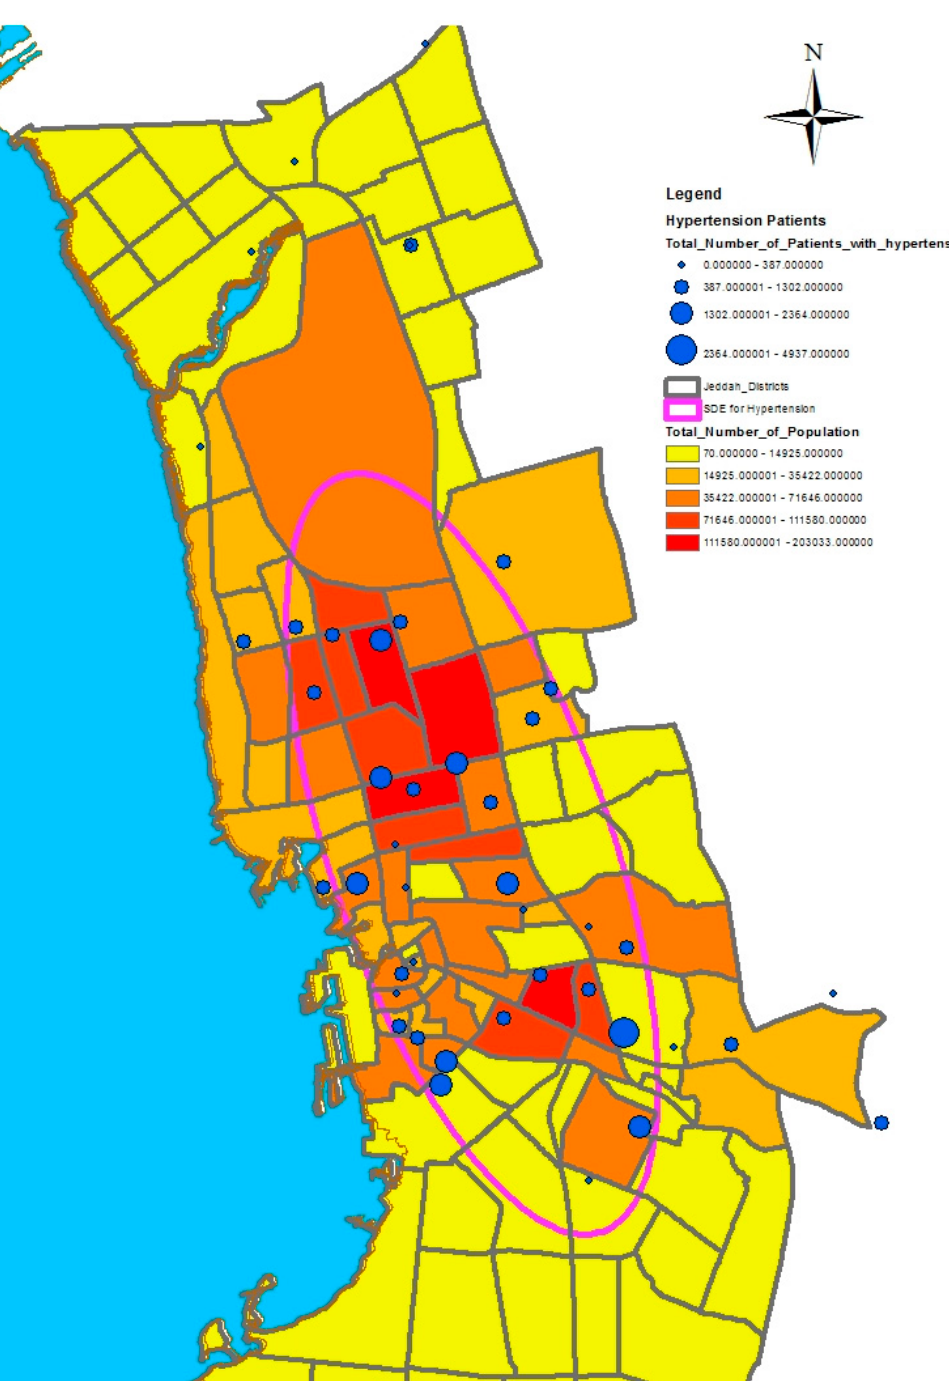
Figure 5. Standard deviational ellipses for hypertension patients.